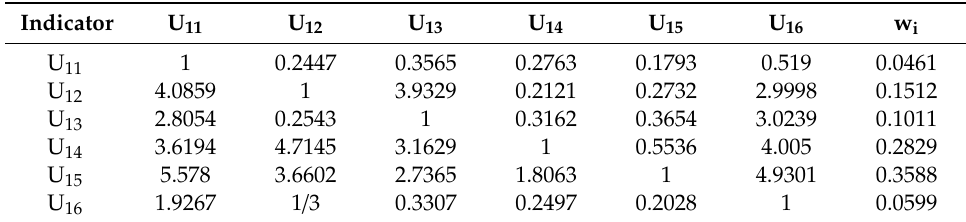
Table 5. Revised weight matrix of ecological benefits.